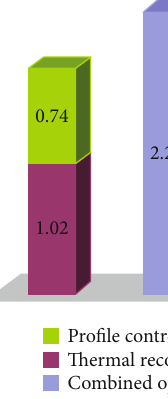
Figure 8: Comparison of accumulative oil increment (10 4 m 3